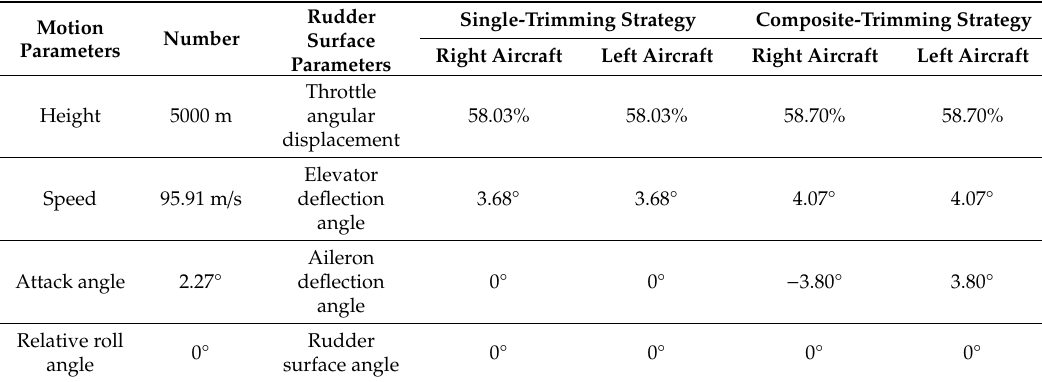
Table 3. Aerodynamic database acquisition